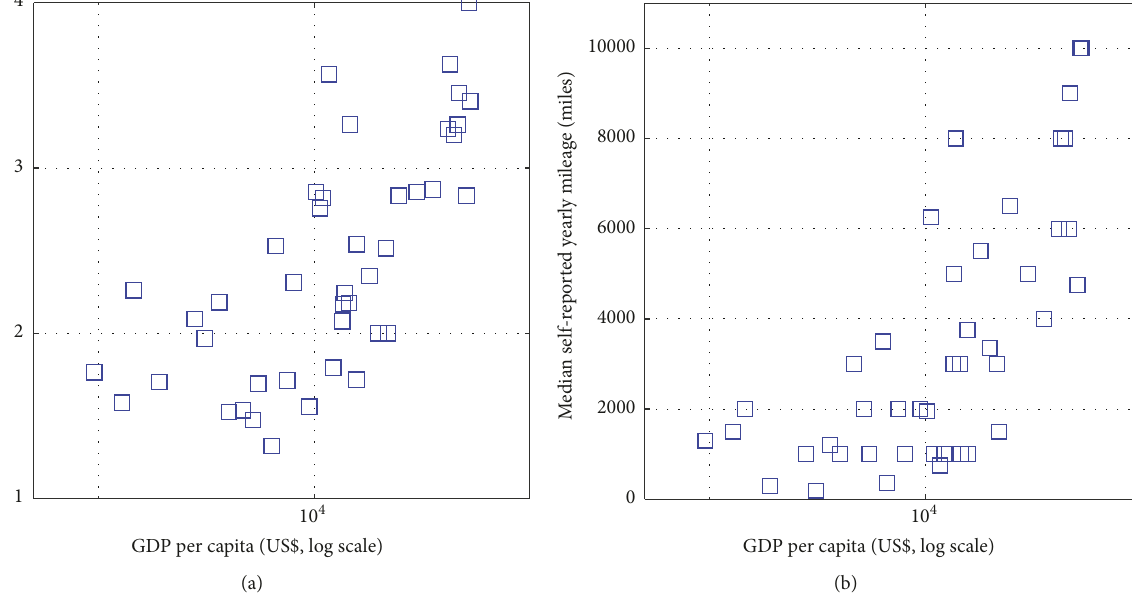
Figure 4: Correlation between countries’ gross domestic product (GDP) per capita and participants’ mean self-reported net household income (a) and participants’ median self-reported yearly mileage (b). Each marker represents a country with 25 or more respondents ( 𝑛 = 43